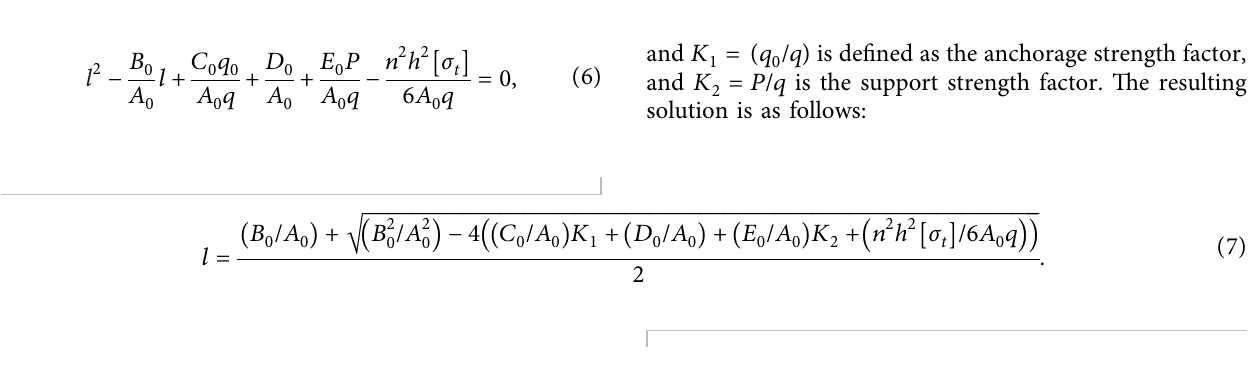
Figure 4: Cantilever-beam bending moment.